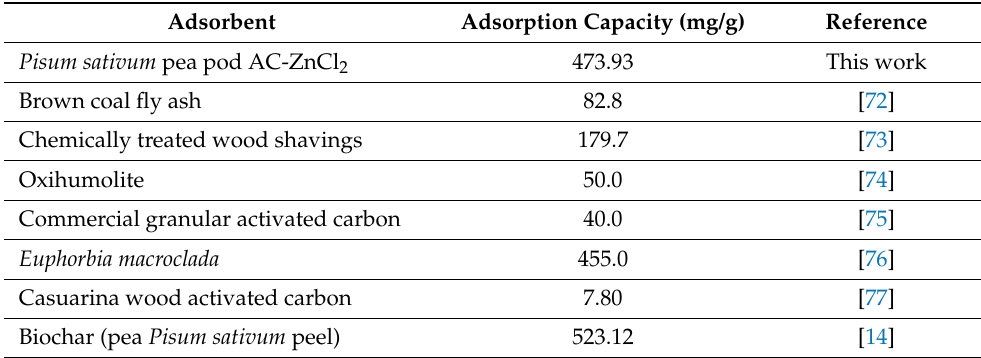
Table 5. Comparative study of the adsorption capability of AO7 dye on various adsorbents.